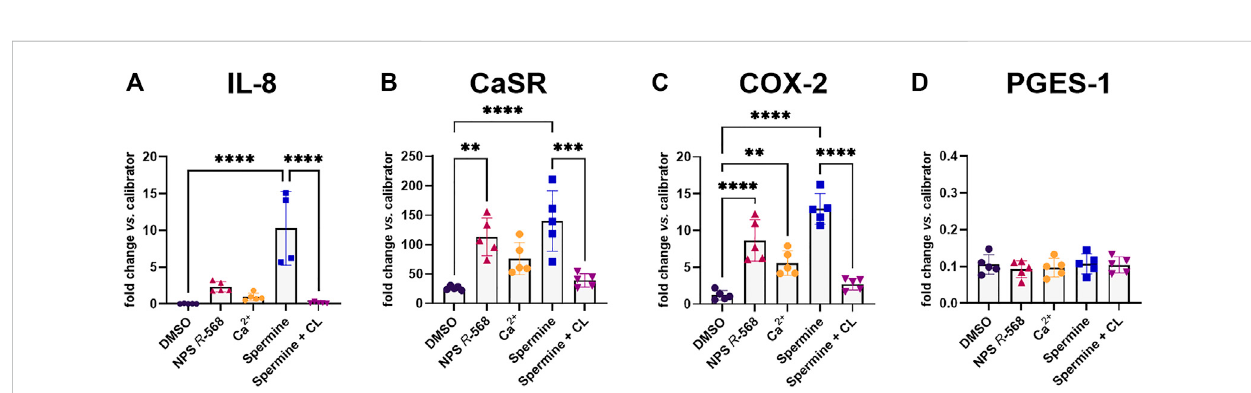
FIGURE 6 Gene induction and suppression by CaSR ligands in Caco-2 CaSR − GFPcells . Relative gene expression of (A) IL-8, (B) CaSR, (C) COX-2, and (D) PGES-1 in Caco-2 CaSR − GFP cells after 4 h treatment with either vehicle control (0.1% DMSO), 1 µM NPS R -568, CaSR ligands (5 mM Ca 2+ , and 5 mM spermine), or